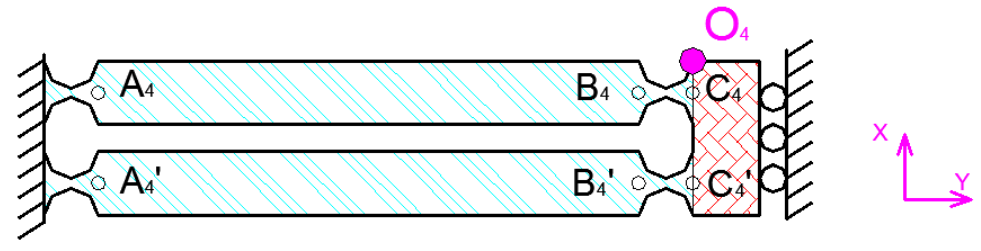
Figure 11. Analysis of x -direction hinge.